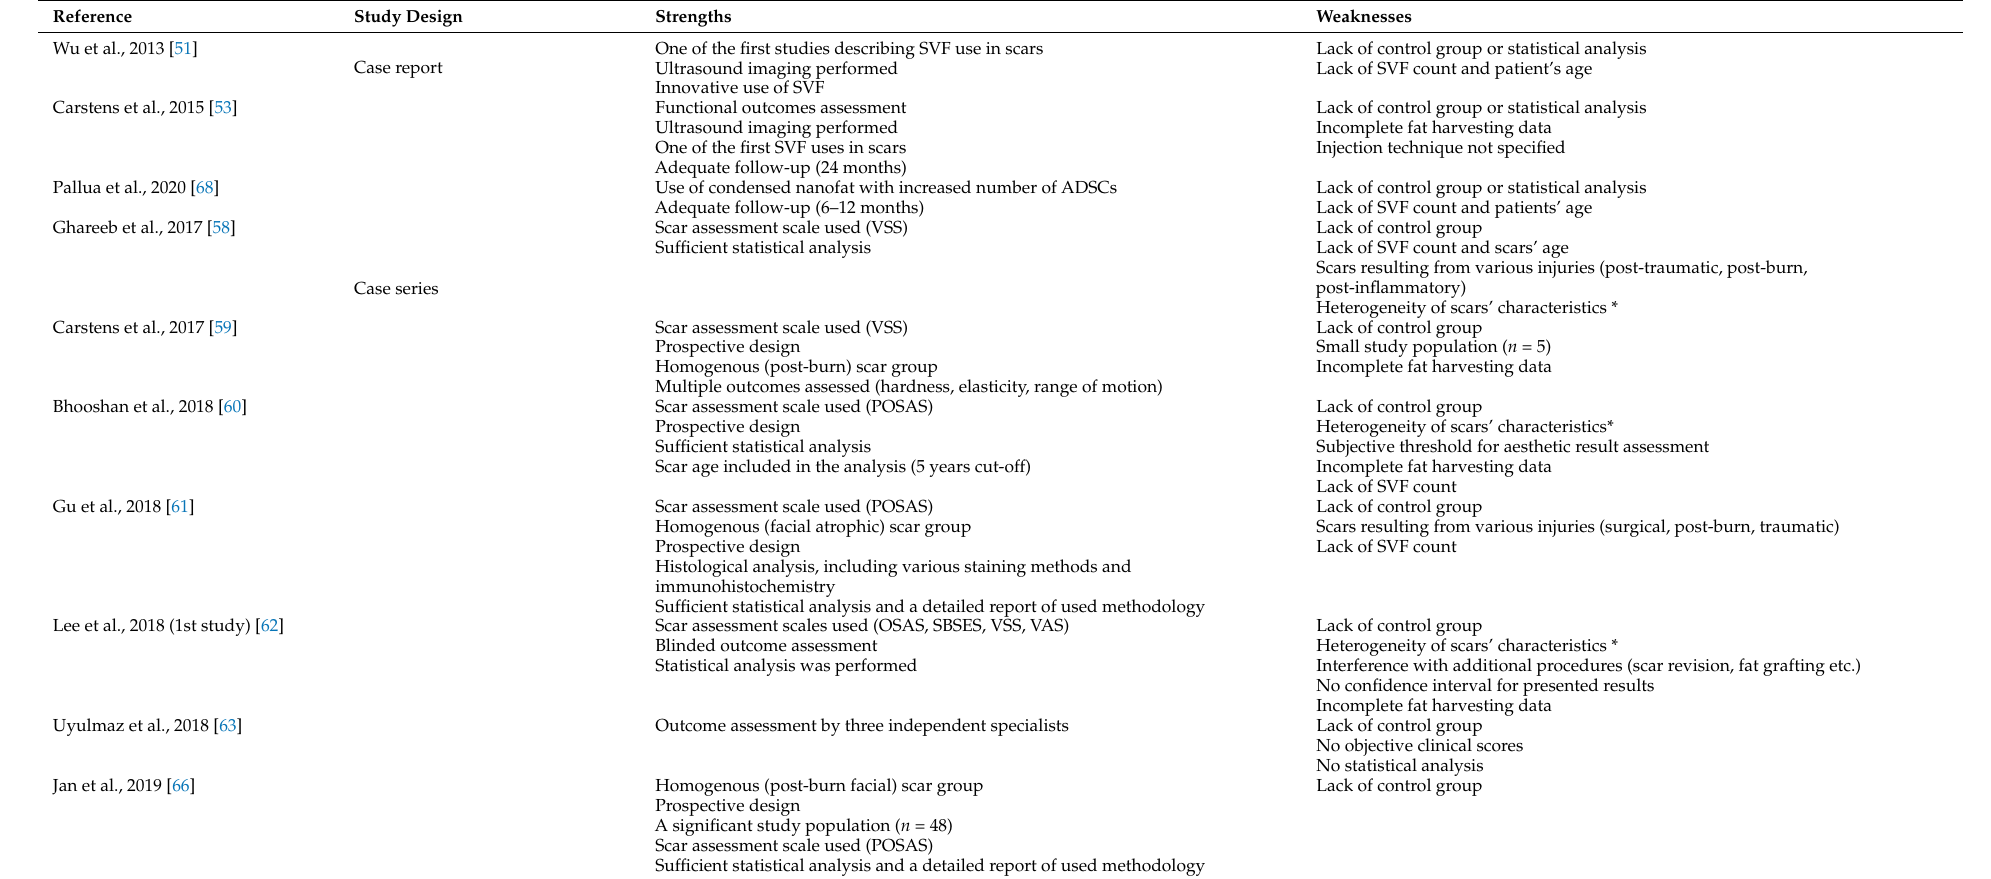
Table 2. Strengths and weaknesses of non-randomized